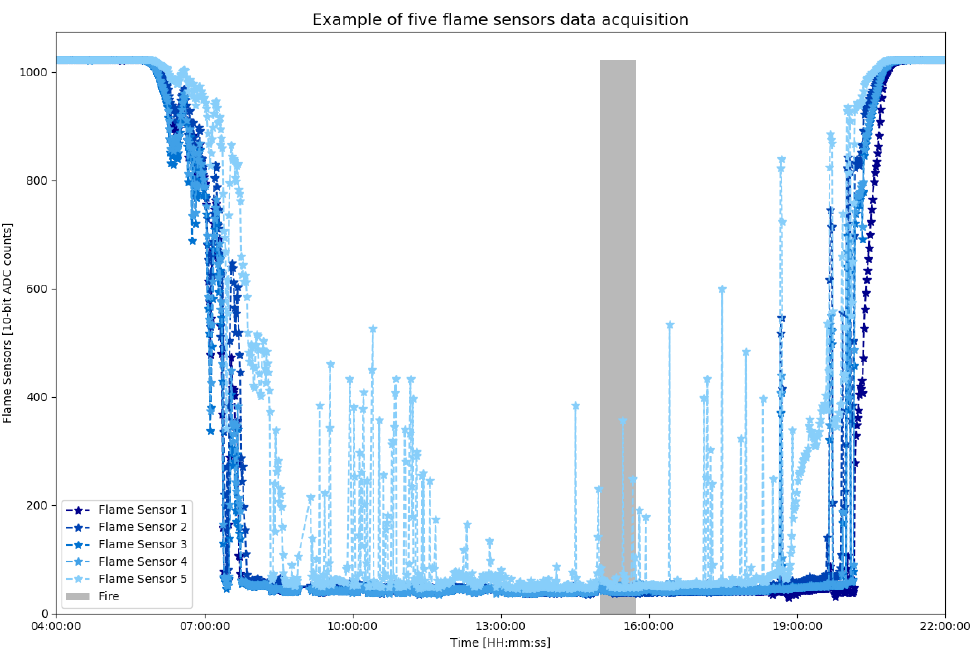
Figure 5. Flame sensors raw data from an example of a sensor module attached to a tree trunk during a fire assay.